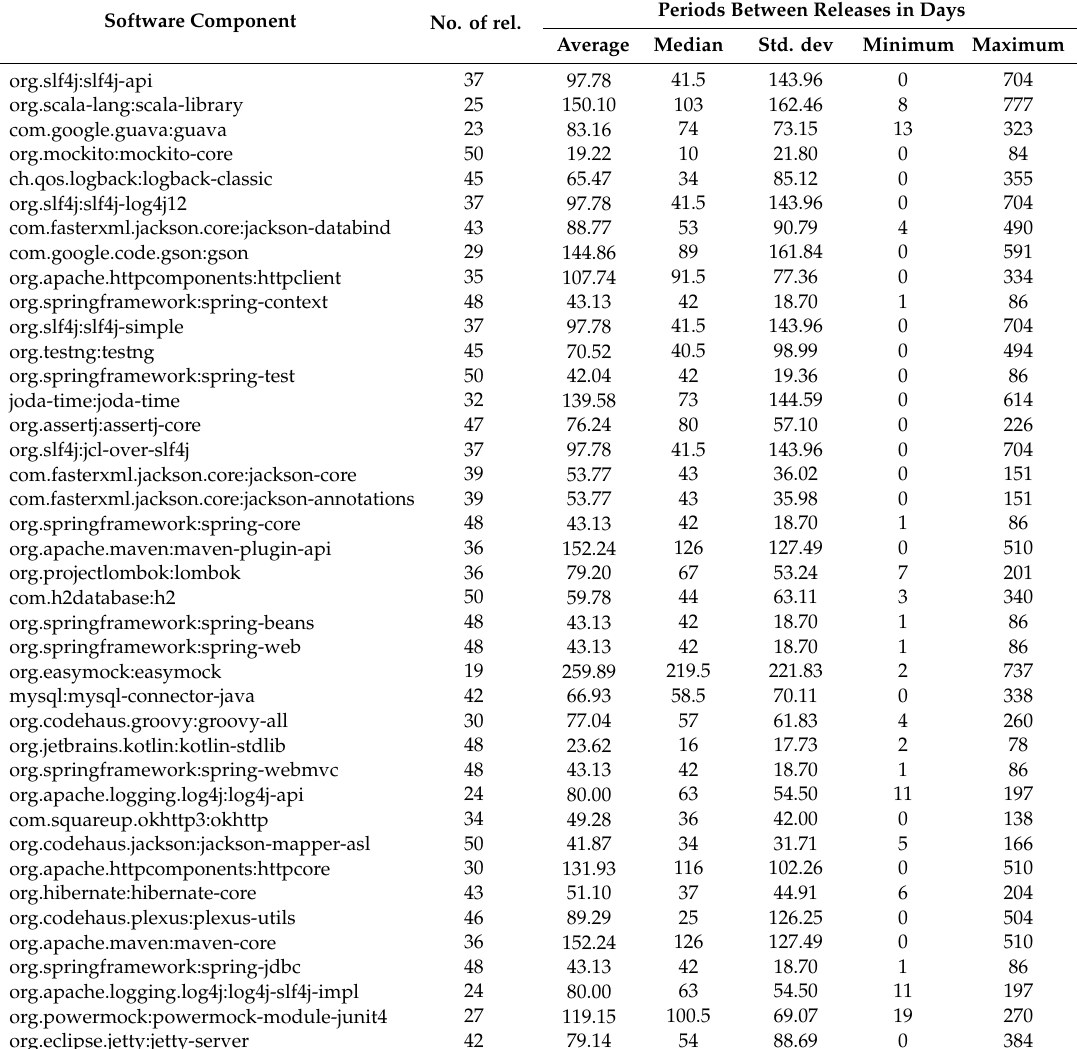
Table A2. Statistical data on periods between releases of the